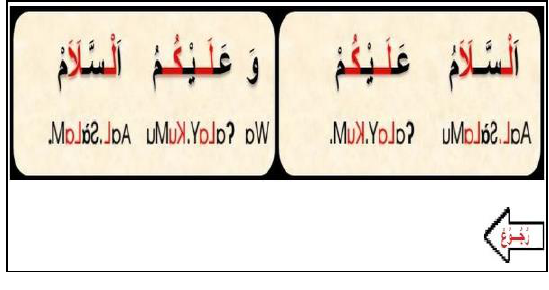
Figure 17. Phonetics transcription support in the e-Learning system